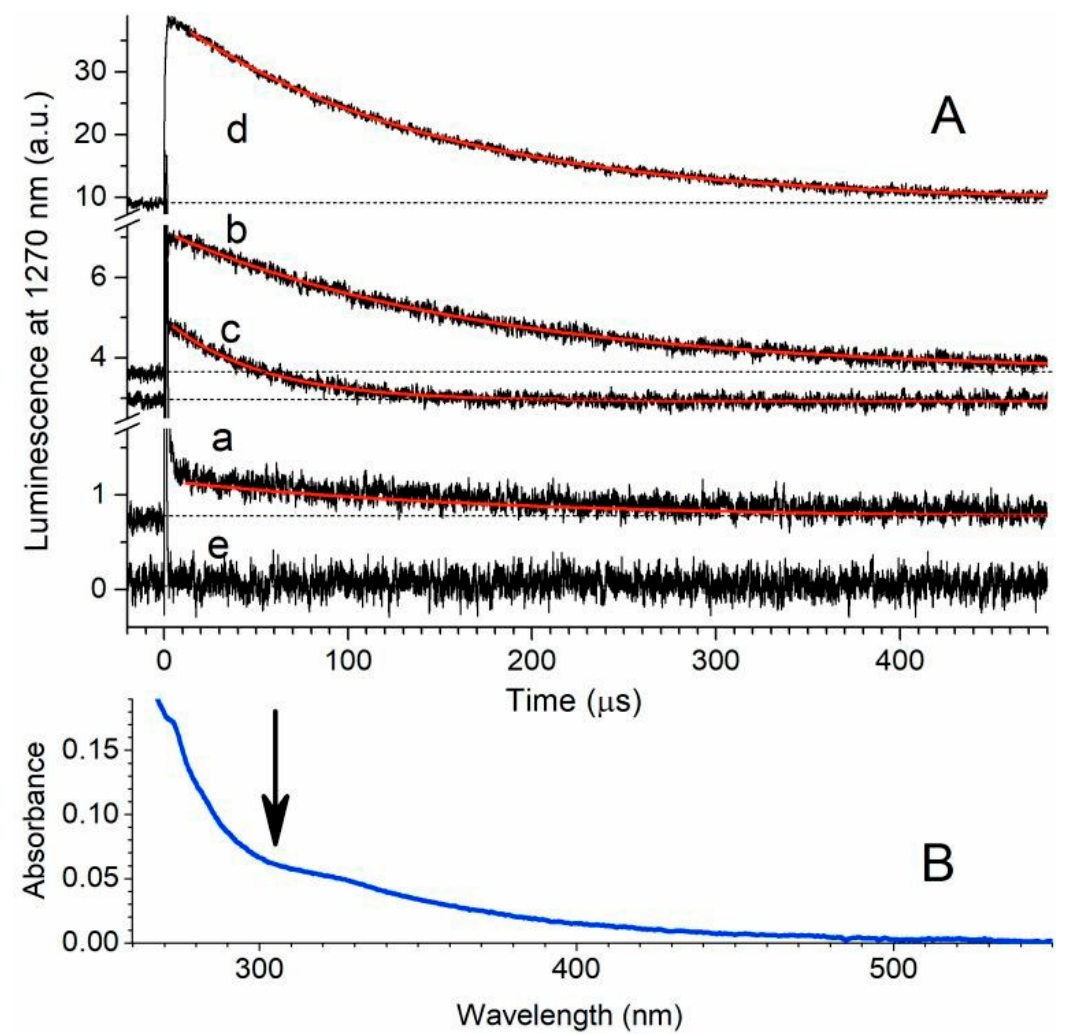
Figure 5. Panel A : Kinetics of O 2 ( 1 Δ g ) luminescence after excitation by laser pulse (wavelength 308 nm and pulse width ~28 ns): SF on steel immersed in air-saturated chloroform ( a ); extract from SC-500 in air-saturated chloroform before ( b ) and after addition of methanol ( c ); standard anthracene in air-saturated chloroform ( d ); and extract from SC-500 in argon-saturated chloroform ( e , no generation of singlet oxygen) for comparison. Red lines are single exponential fits into experimental data. Individual traces are offset. Panel B : UV–Vis spectrum of the extract from SC-500 in chloroform, arrow designates excitation